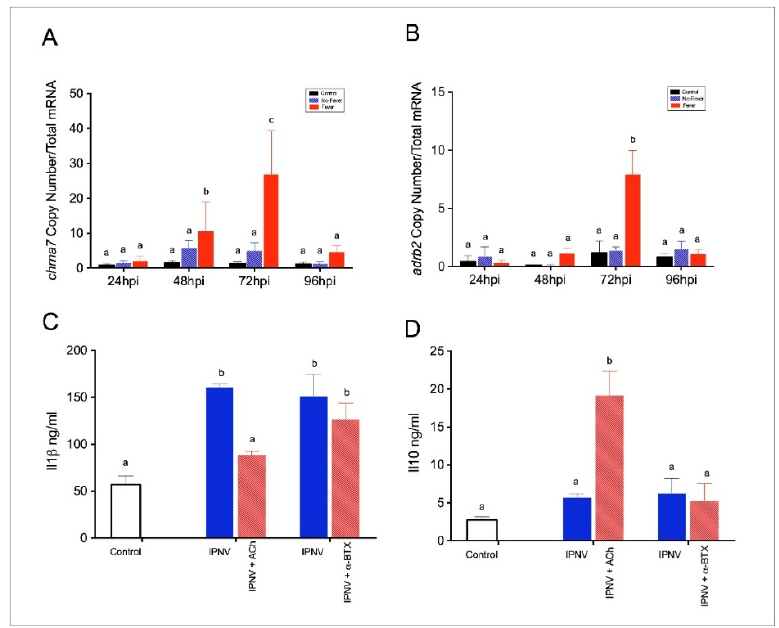
Figure 7. Expression profiles among neuroregulatory receptors. ( A ) adrb2 and ( B ) chrna7 in spleen of IPNV-challenged individuals. Bar graphs showing significant differences in mRNA abundances between control uninfected (black bars), no-fever (dashed blue bars), and fever (red bars) individu- als at 48 and 72 hpi (mean ± SD, two-way ANOVA followed by Tukey’s post hoc test, p < 0.05). The mean and standard error (SD) value for the copy number of chrna7 and adrb2 transcripts per ng of